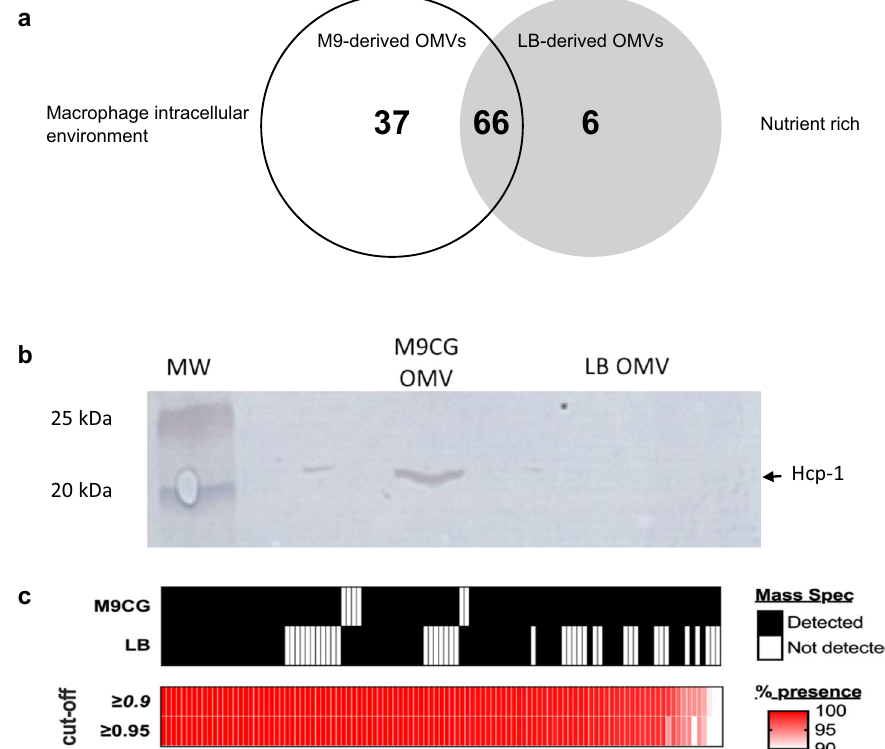
Fig. 1 OMVs derived from B. pseudomallei grown in M9 media are enriched in intracellular-stage proteins. a Venn diagram depicting the unique and shared proteins found in OMVs derived from Bp grown in M9 versus LB media. 109 proteins are shown across the two preparations. b Presence of Hcp-1 was con fi rmed in M9 OMVs by Western blot with rat anti-Hcp-1 sera. Hcp-1 band is shown at 21 kDa. MW molecular ladder. c Large-scale blast score ratio (LS-BSR) for protein presence and conservation among B. pseudomallei . The conservation of proteins in the M9 and LB preparations was compared using tblastn LS-BSR analysis using coding regions from 407 sequenced B. pseudomallei genomes. Protein conservation was determined by blast score ratio cut-offs of ≥ 0.9 or ≥ 0.95. The percentage of the 407 tested genomes that contained each protein are shown in the heat map where <90% are shown in white and 100% are shown in